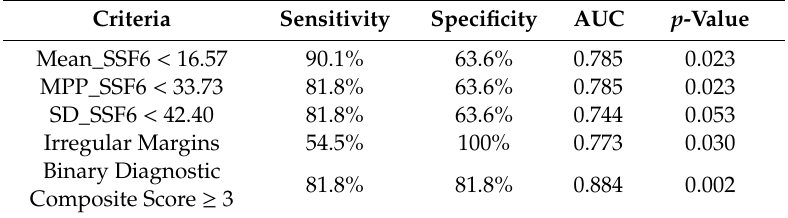
Table 4. Identification of RPHCC. Diagnostic criteria based on results from CT texture features. Mann–Whitney analysis of sensitivity, specificity, area under the curve (AUC) and p -value.